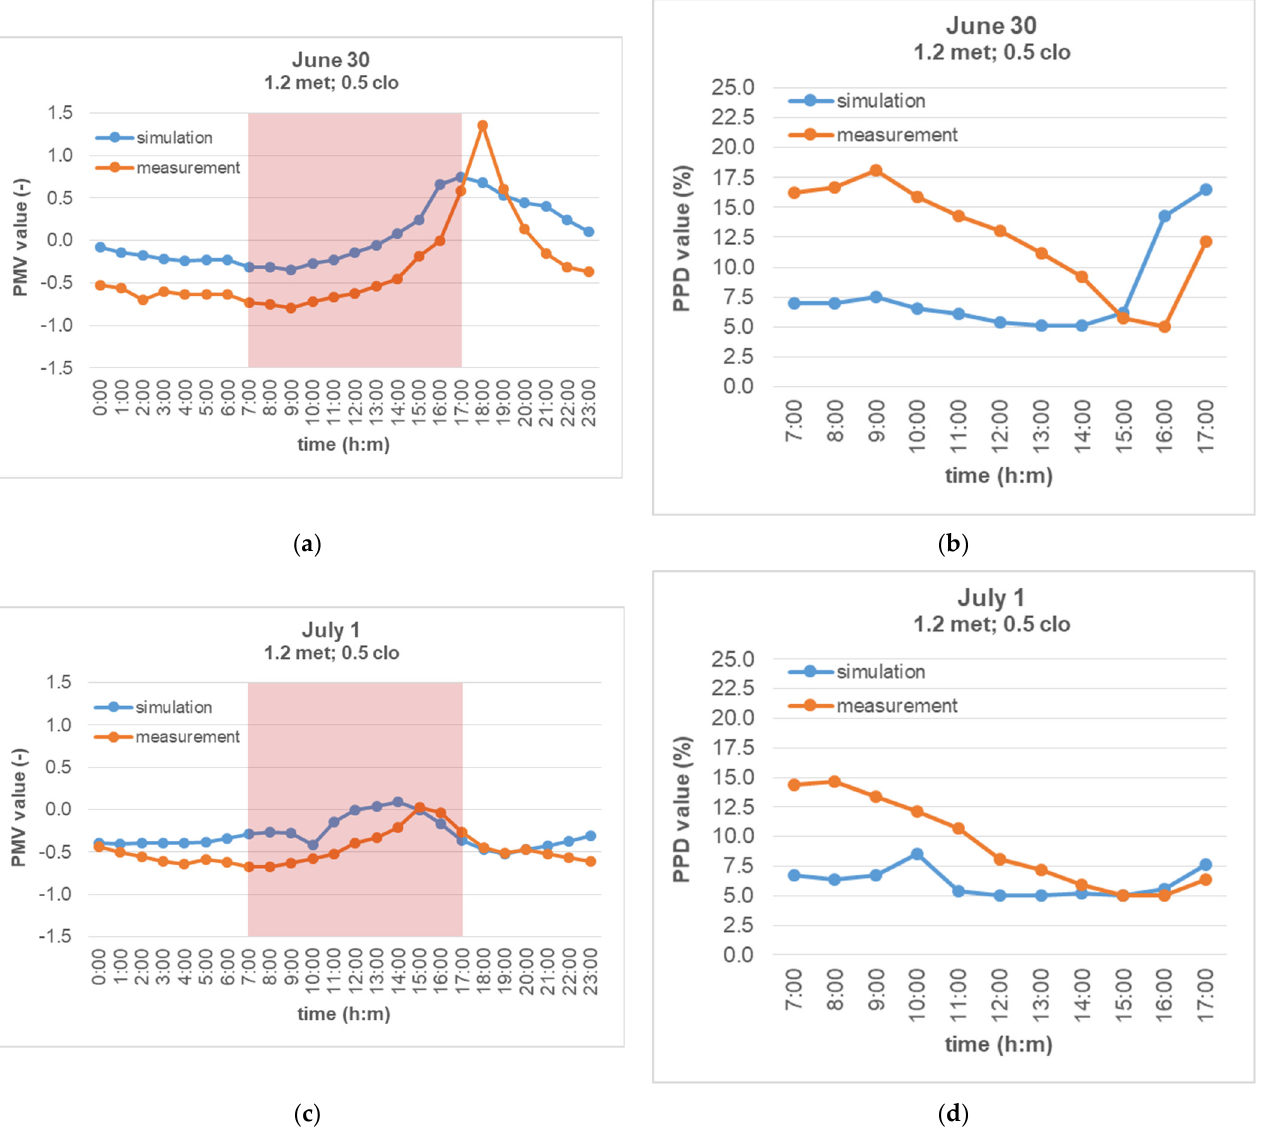
Figure 13. Evaluation of PMV and PPD indices using the typical values of metabolism (1.2 met) and clothing resistance (0.5 clo): ( a ) PMV on 30 June, ( b ) PPD on 30 June, ( c ) PMV on 1 July, ( d ) PPD on